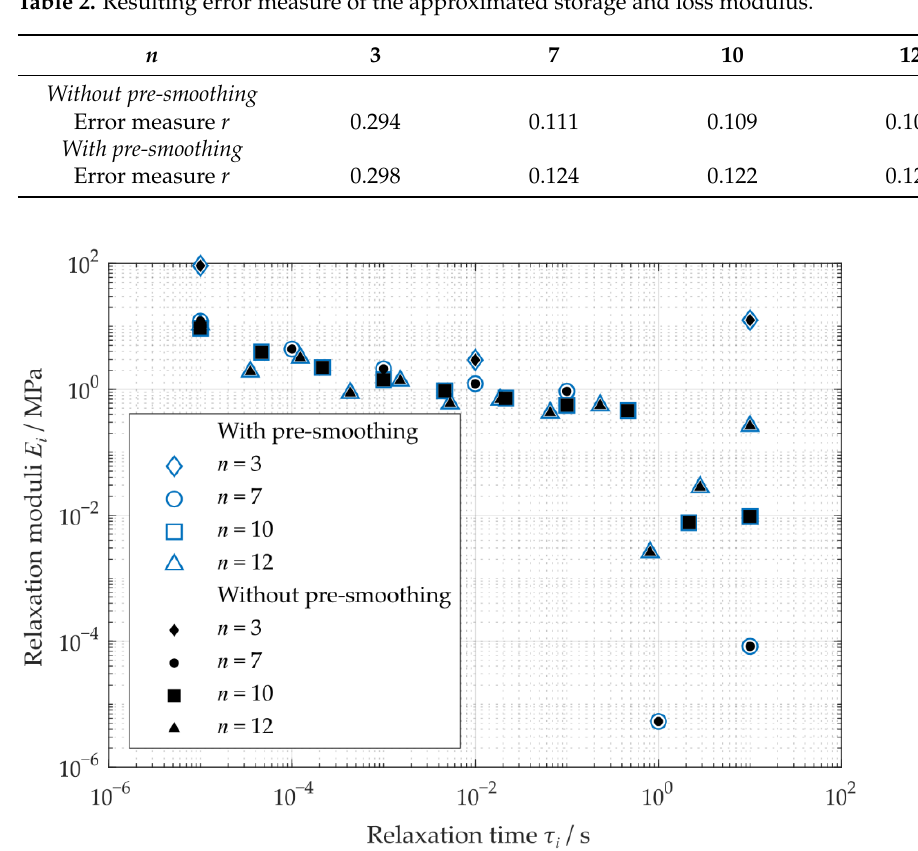
Figure 8. Resulting relaxation moduli of Prony-series of the generalized Maxwell model without and with pre-smoothing.